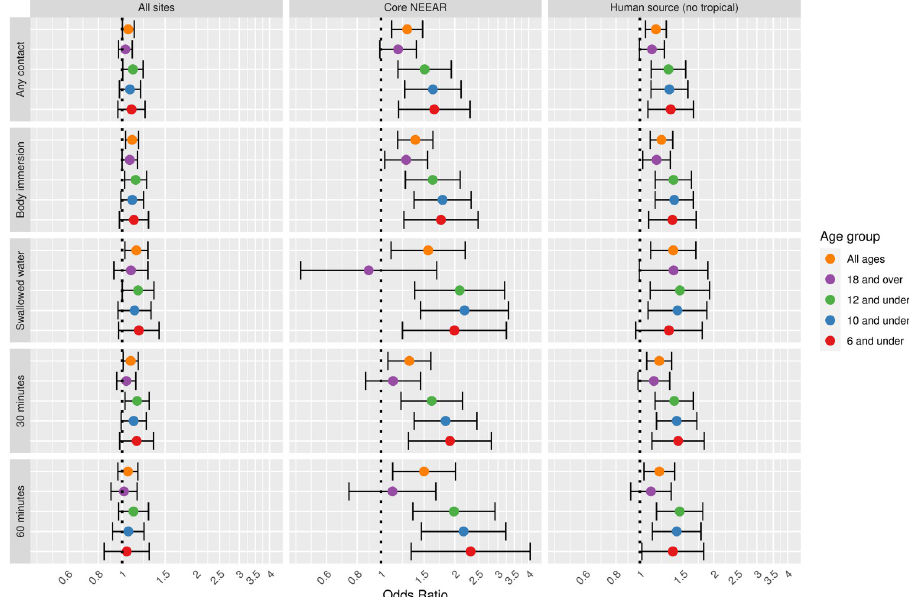
Fig 1. Odds ratios for NEEAR-GI illness among swimmers associated with a 1-log 10 increase in Enterococcus qPCR CE.